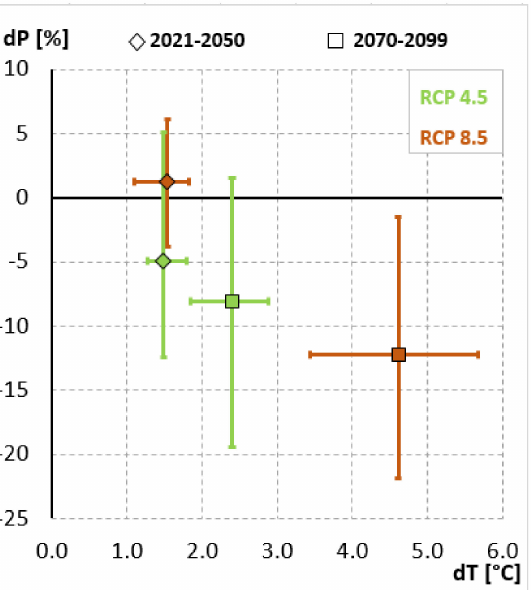
Figure 1. Expected change of temperature ( dT ) and precipitation ( dP ) in the summer quarter (June– July–August) in southwest Hungary at the xeric limits of silver fir based on the RCP4.5 and RCP8.5 scenarios. Reference: mean of 1971 to 2000. Dots: ensemble means (10 simulations) of the projected changes. Error bars: 66% range of the simulations (original design by B. G á los, method of calculation described in